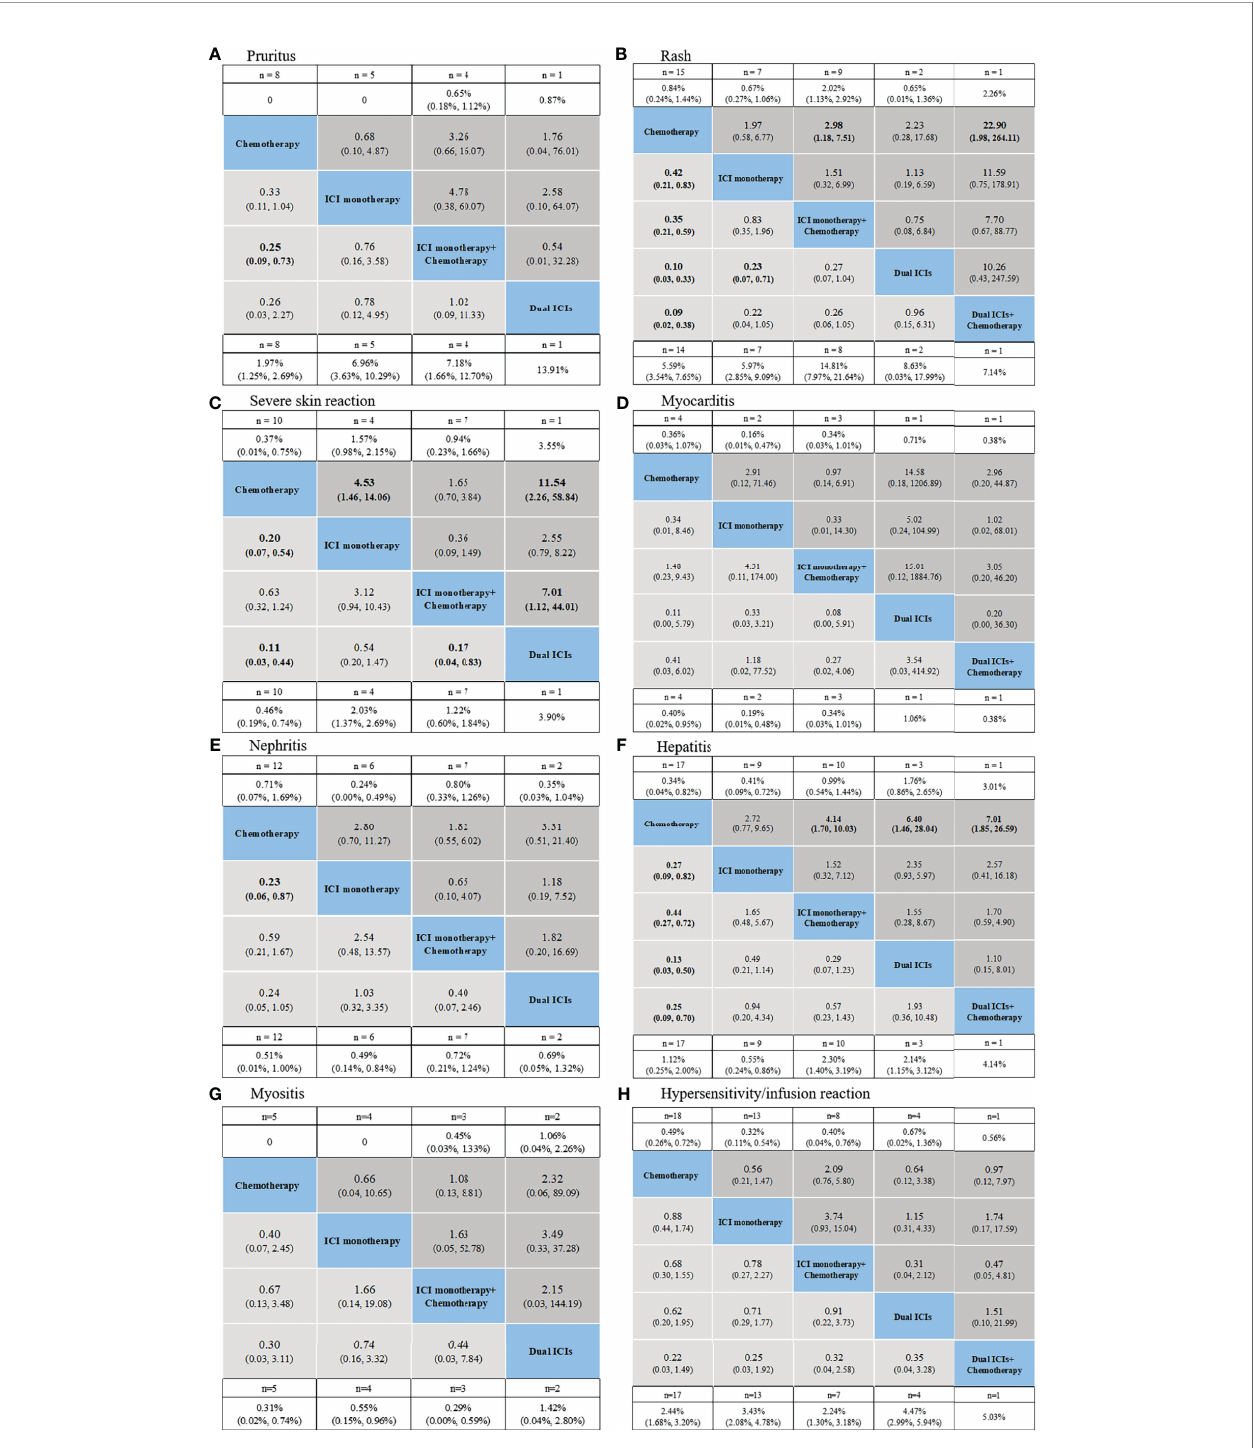
FIGURE 5 | Safety pro fi les based on speci fi c organs: pruritus (A) , rash (B) , severe skin reaction (C) , myocarditis (D) , nephritis (E) , hepatitis (F) , myositis (G) , hypersensitivity/infusion reaction (H) . Pooled incidences and 95% con fi dence intervals of grade 1 – 5 events for each treatment are at bottom and that of grade 3 – 5 events are at top of the fi gure. Each cell of the safety pro fi les contains the pooled relative risks and 95% con fi dence intervals for grade 1 – 5 (light gray cell) and grade 3 – 5 (dark gray cell) events; signi fi cant results are in bold. The pooled relative risks and 95% con fi dence intervals indicate the results of the top treatment compared with the bottom treatment. ICI, immune checkpoint inhibitor; n,